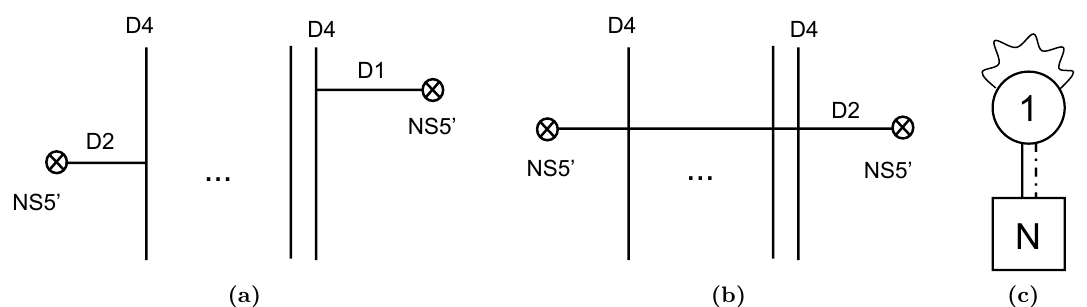
Figure 12. (a) The brane configuration for an ’t Hooft loop with magnetic charge B = e N − e 1 . (b) A D2-brane suspended between two D4-branes is introduced to describe ’t Hooft-Polyakov monopole with magnetic charge v = − e N + e 1 . When the vertical position of three segments of D2- branes coincide, the D2-branes combined into signle D2-brane suspended between two NS5’-branes. Then the magnetic charge are completely screened. (c) The quiver diagram for SQM for the D2- brane world volume theory of (b). The solid line denotes 1d hypermultiplets. The dash-dotted line denotes long Fermi multiplets. The wavy line denotes a free twisted